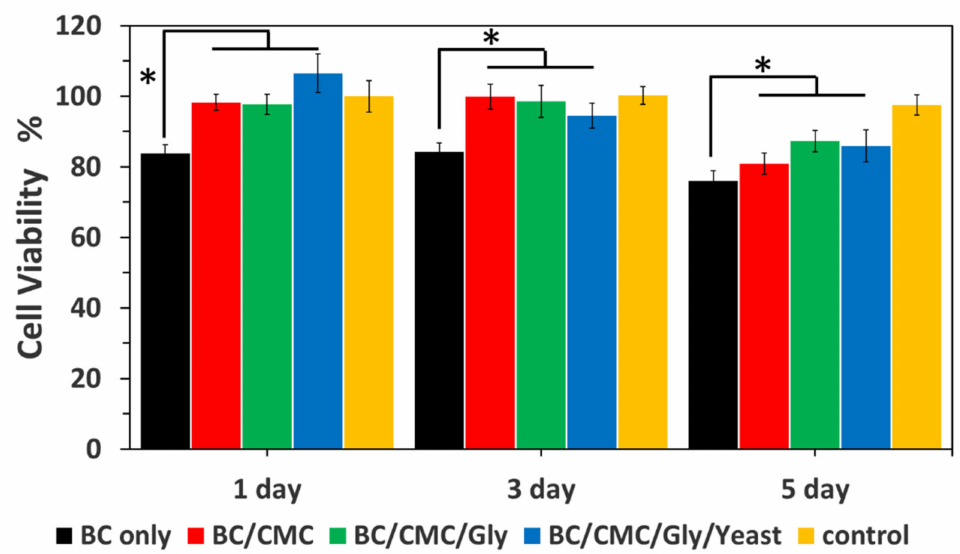
Figure 6. Viability of NIH-3T3 fibroblasts on pristine BC, BC/CMC, BC/CMC/Gly, and BC/CMC/Gly/yeast films after incubation for 1, 3, and 5 days, * p < 0.05. The absorption was recorded at 570 nm for all